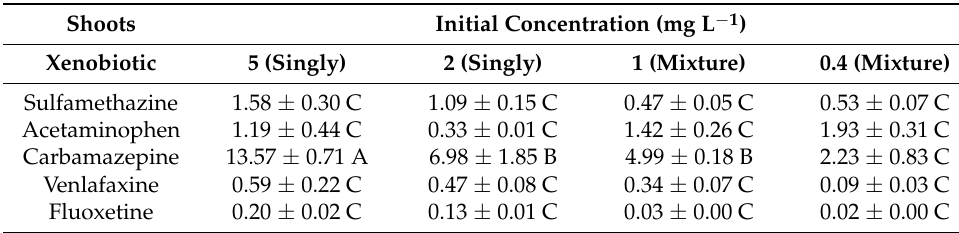
Table 3. Xenobiotic concentration in shoots in Tripolium pannonicum . The values 5 and 2 in the table header represent the singly xenobiotic concentration and the values 1 and 0.4 represent each xenobiotic concentration in a mixture of the five xenobiotics in mg L − 1 . Values show the mean (in µ g g − 1 FM) ± standard error of three biological replicates per treatment.